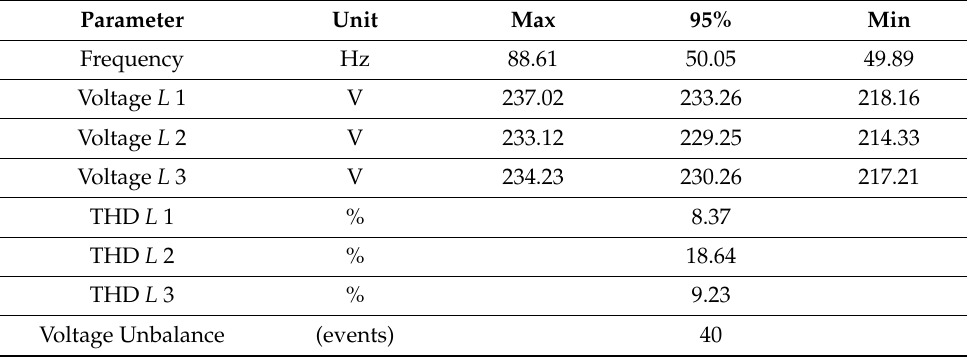
Table 1. Basic parameters of the supply voltage according to EN 50160.